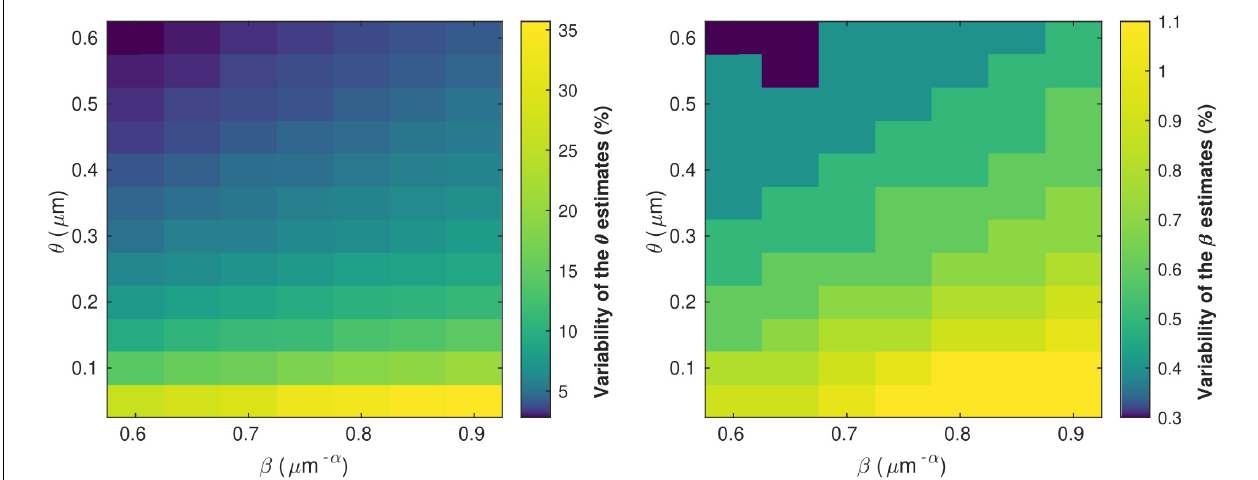
FIGURE 5 | Variability of the θ (left) and β (right) parameter estimates due to noise in the in vivo samples of g MRI and V . The highest errors in θ ( ∼ 35%) are found for the smallest values of θ , with only a small effect of the parameter β . The highest errors in β ( ∼ 1%) are obtained from a combination of small values of θ and large values of β .